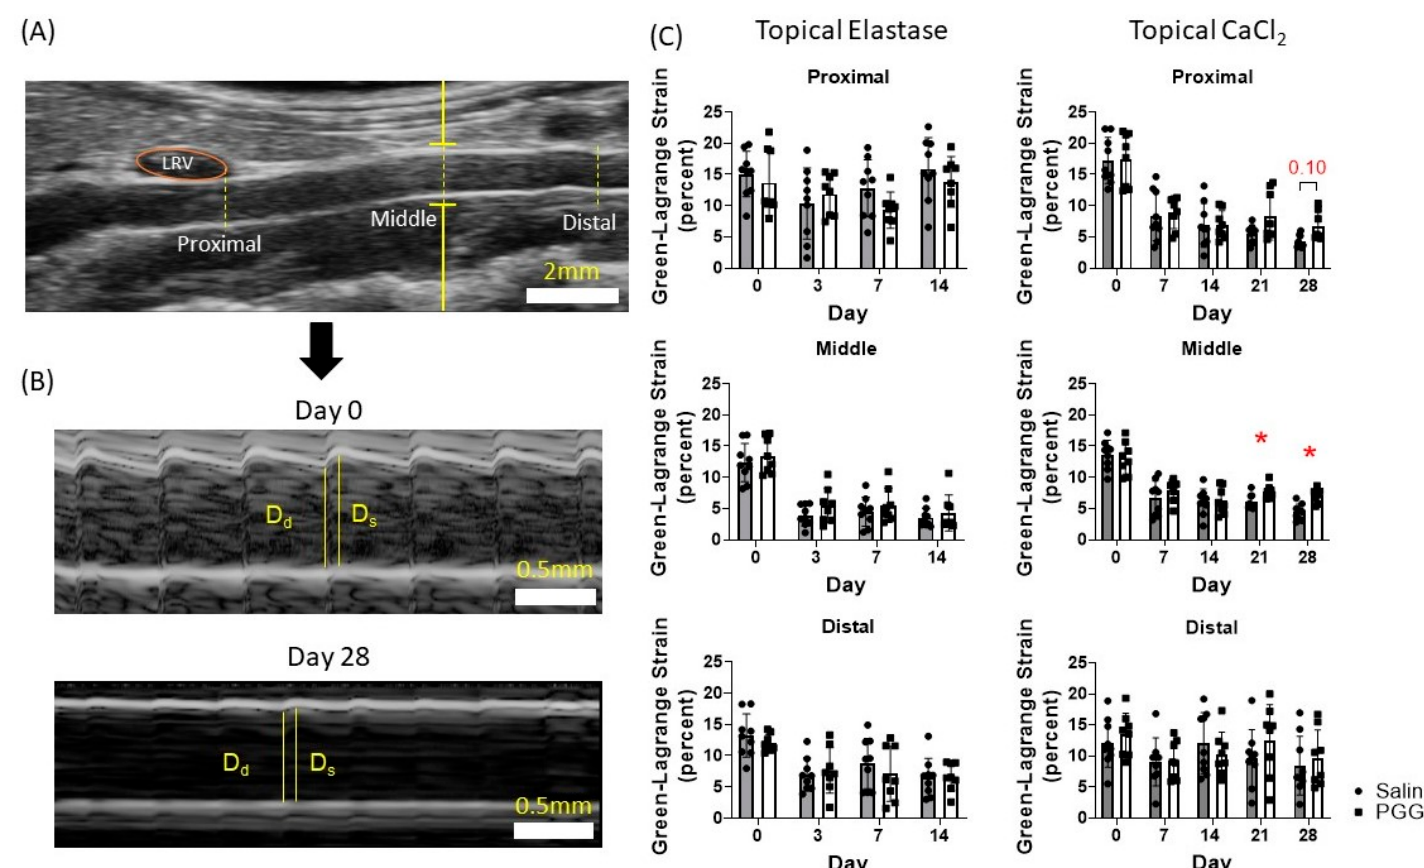
Figure 4. Green–Lagrange circumferential cyclic strain analysis. ( A ) M-mode acquisitions were taken at the proximal, middle, and distal infrarenal aorta. Representative locations are shown. LRV, left renal vein. ( B ) M-mode acquisitions at day 0 and at day 28 in the CaCl 2 -injured model demonstrating reduced compliance and measurement of the diastolic and systolic luminal diameters used to calculate Green–Lagrange circumferential cyclic strain, Equation (2). Systolic and diastolic measurements were made in triplicate and averaged, and the averages used to calculate Green–Lagrange circumferential cyclic strain. D d , diastolic diameter. D s , systolic diameter. ( C ) Green–Lagrange circumferential cyclic strain at each location in the topical elastase and CaCl 2 groups. No difference in strain between saline or PGG treatment was seen in the topical elastase group. A statistically significant difference in strain was seen between treatments at the middle location in the CaCl 2 group. Strain between treatments approached significance at the proximal location in the topical CaCl 2 group.